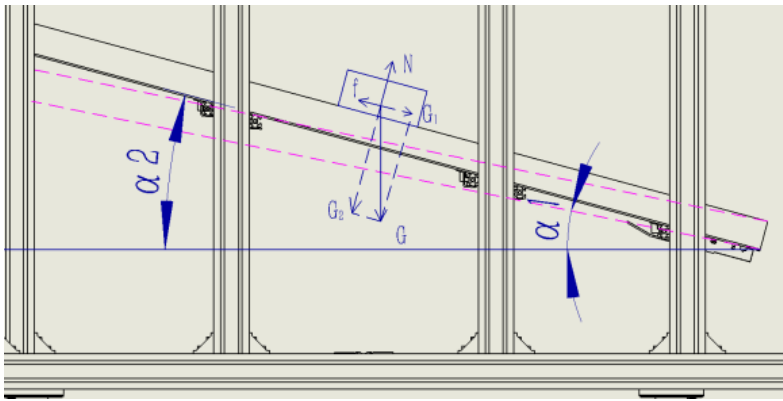
Figure 2. U-shaped storage position and medicine storage tank.